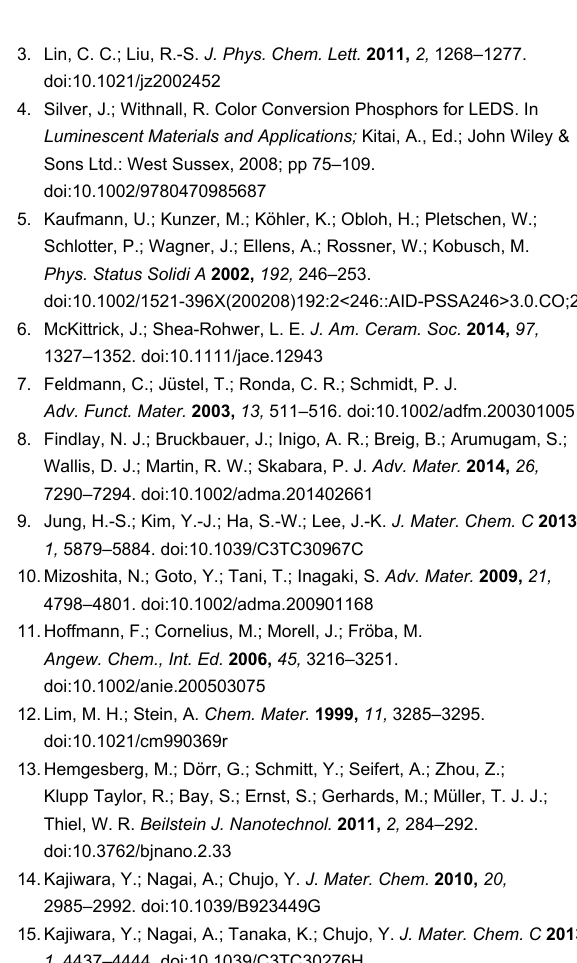
Figure 11: CIE chromaticity coordinates of the coated LEDs in compact device set-up (SMD) and conventional diode design (LED) in the CIE 1931 color space (2° standard observer).